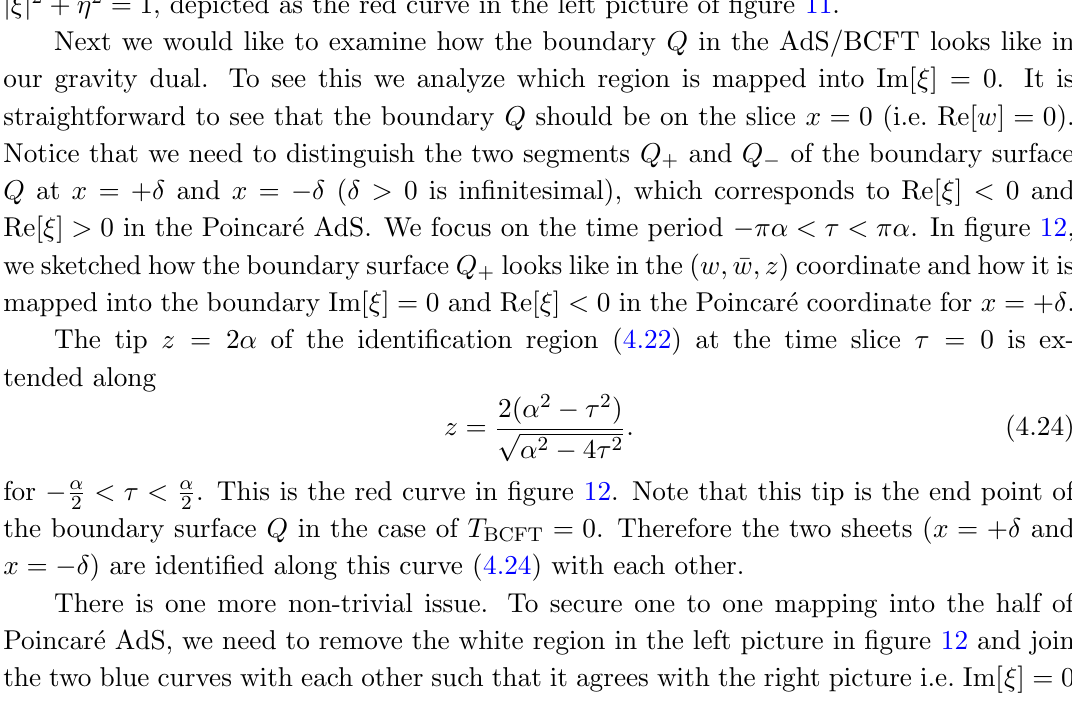
Figure 11 . The map (2.12) between the gravity dual of splitting local quench (left) and the upper Poincar(cid:19)e AdS (right). The red curve in the left is given by z = 2( x 2 + (cid:11) 2 ) curve should be removed with the identi(cid:12)cation x with (cid:0) x on the curve. The length of red curve gives the HEE between two separated lines. The green and dark brown curve describe the boundary surface Q